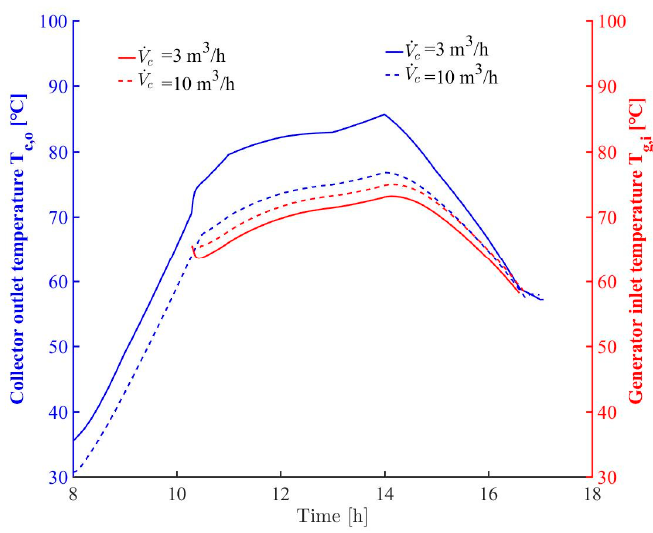
·  ff erent V c V . Figure 6. Hot water temperature for di c